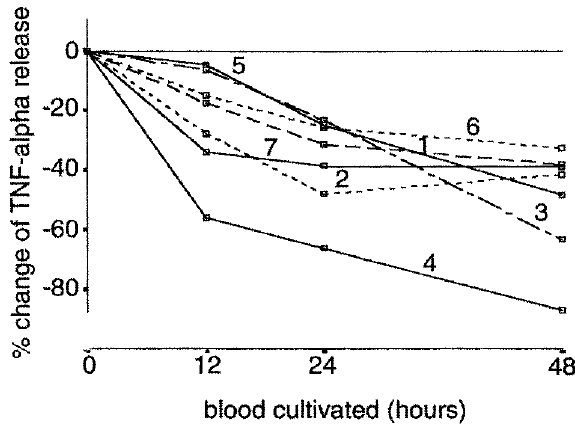
FIG. 1. Changes in tumor necrosis factor- a (TNF- a ) release in lipopolysaccharide (LPS)-stimulated blood cultures of seven healthy women 24h after ingestion of 80mg aspirin. Venous blood, sampled immediately before and 24h after oral intake of 80mg aspirin, was diluted 1:10 in complete RPMI and cultivated for 48h in the presence of Escherichia coli O111 B4 LPS. Blood cultures were sampled at 0, 12, 24 and 48h, and supernatants analysed by a screening line immunoassay using a single monoclonal antibody for TNF- a detection. The different lines (1–7) represent TNF- a release 24h after aspirin ingestion as a percentage of values obtained before aspirin intake in seven women (subjects